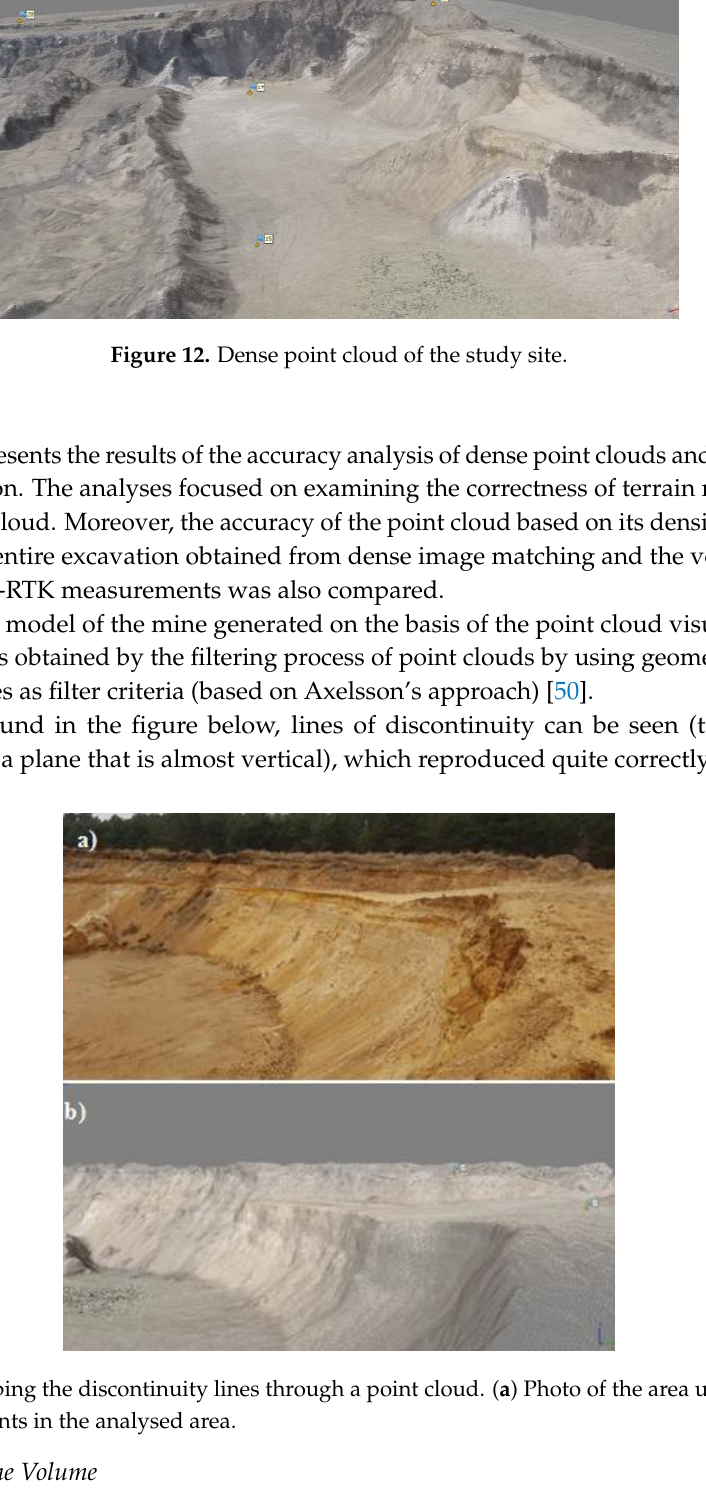
Figure 13. Mapping the discontinuity lines through a point cloud. ( a ) Photo of the area under analysis ( b ) Cloud of points in the analysed area.